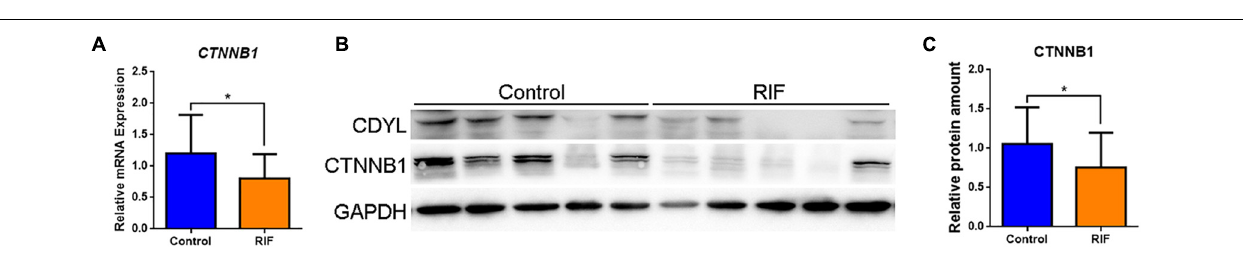
FIGURE 6 | The expression of CTNNB1 was decreased in the endometrium of women with RIF. (A) The mRNA expression levels of CTNNB1 in control ( n = 22) and RIF ( n = 22) groups. (B,C) The protein expression levels of CTNNB1 in the control ( n = 22) and RIF ( n = 22) groups. All data are presented as mean ± SD. * P <